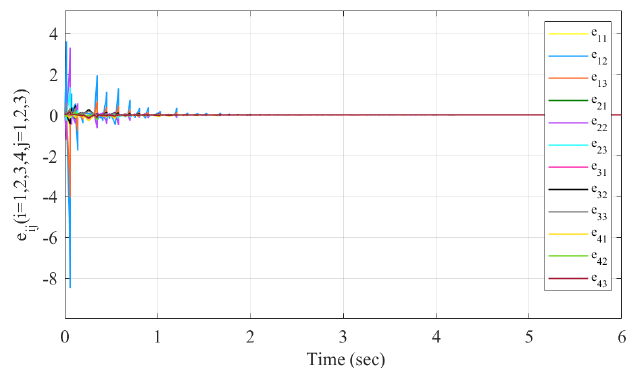
Figure 10. Tracking error trajectories of nodes with event-triggered protocol under DoS attacks.